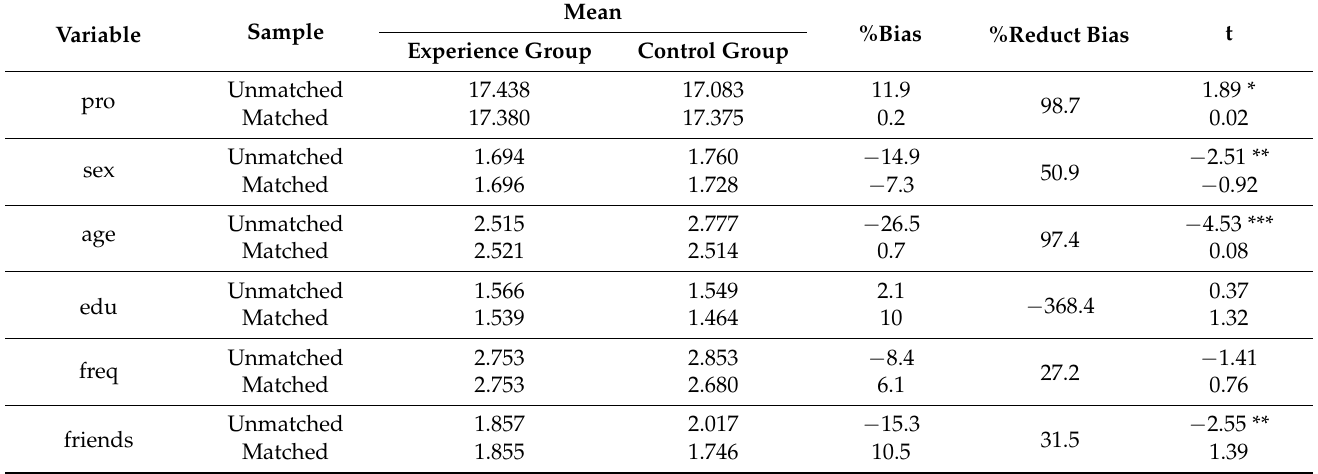
Table 5. Results of the balance test.